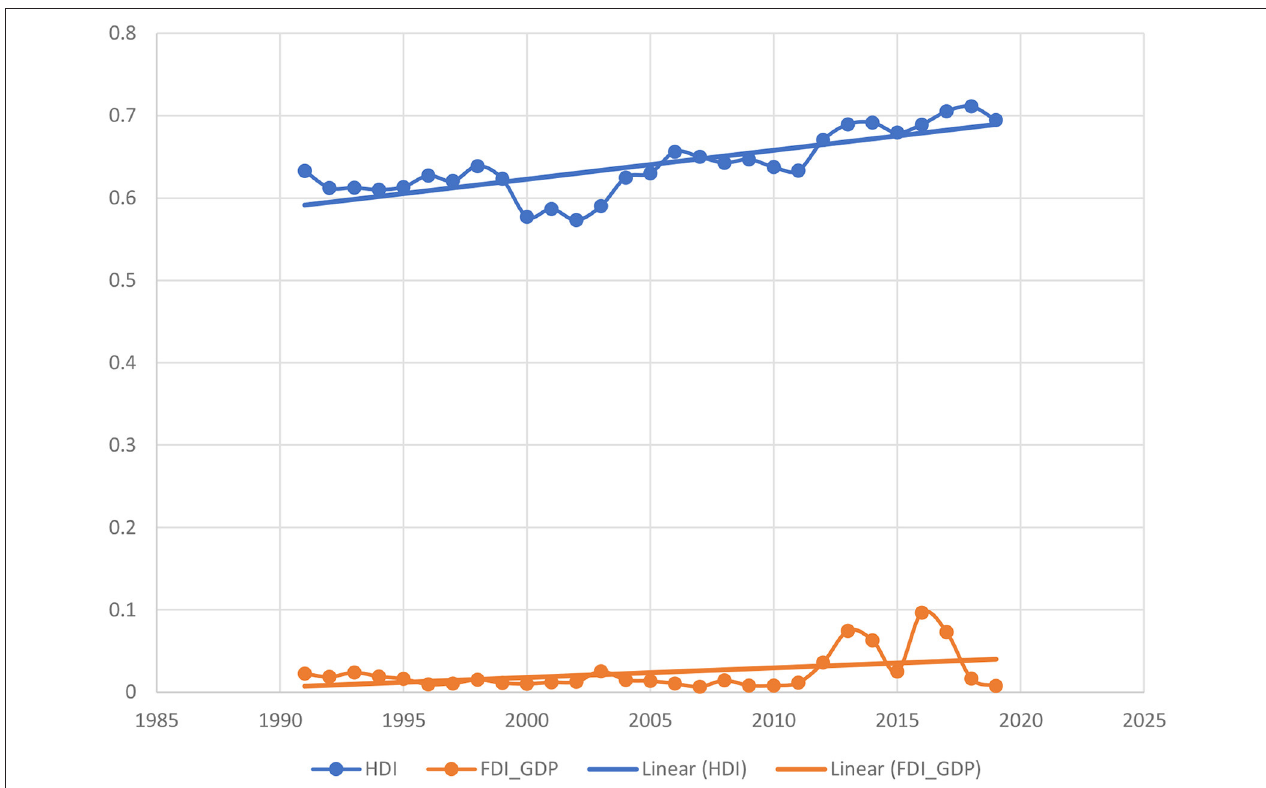
FIGURE 1 | Time path of Welfre and agricultural foreign direct investment in developing countries.